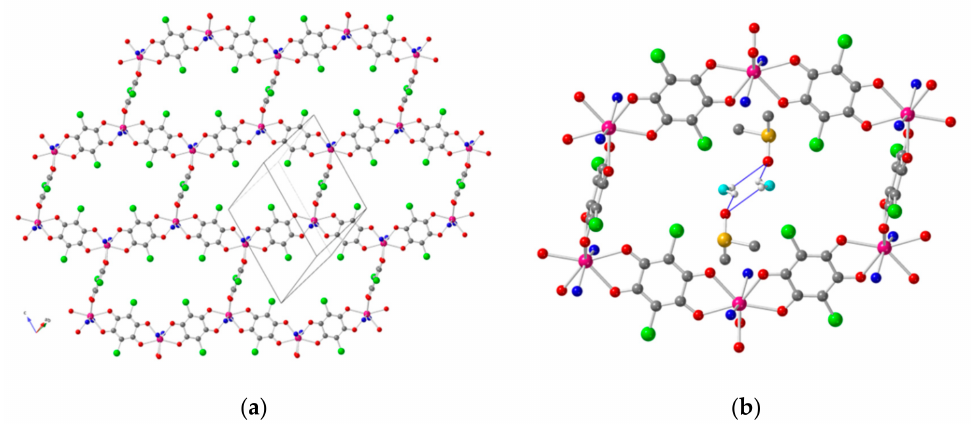
Figure 5. ( a ) Top view of one distorted honeycomb (3,6)-gon layer in 2 ; ( b ) View of one hexagonal ring in compound 2 . Thin blue lines represent the H-bonds between the water molecules and the O atoms of the crystallization dmso molecules. Colour code: Dy = pink, C = grey, S = yellow, Cl = green, O anilato = red, O water = light blue, O dmso = dark blue. Only the O atom of the coordinated dmso molecules is shown. H atoms and crystallization dmso molecules (only in ( a )) have been omitted for